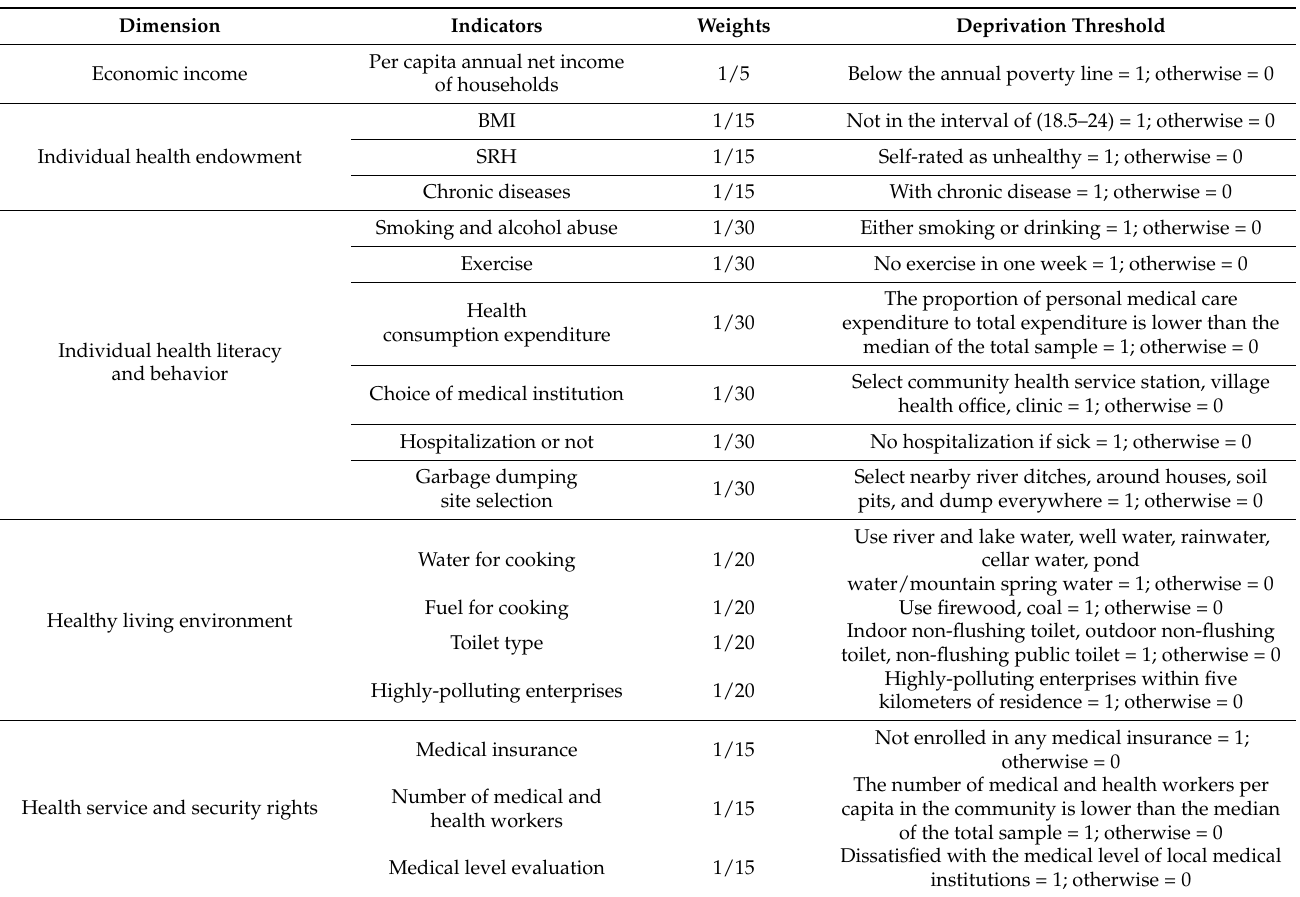
Table 1. Multidimensional health poverty index